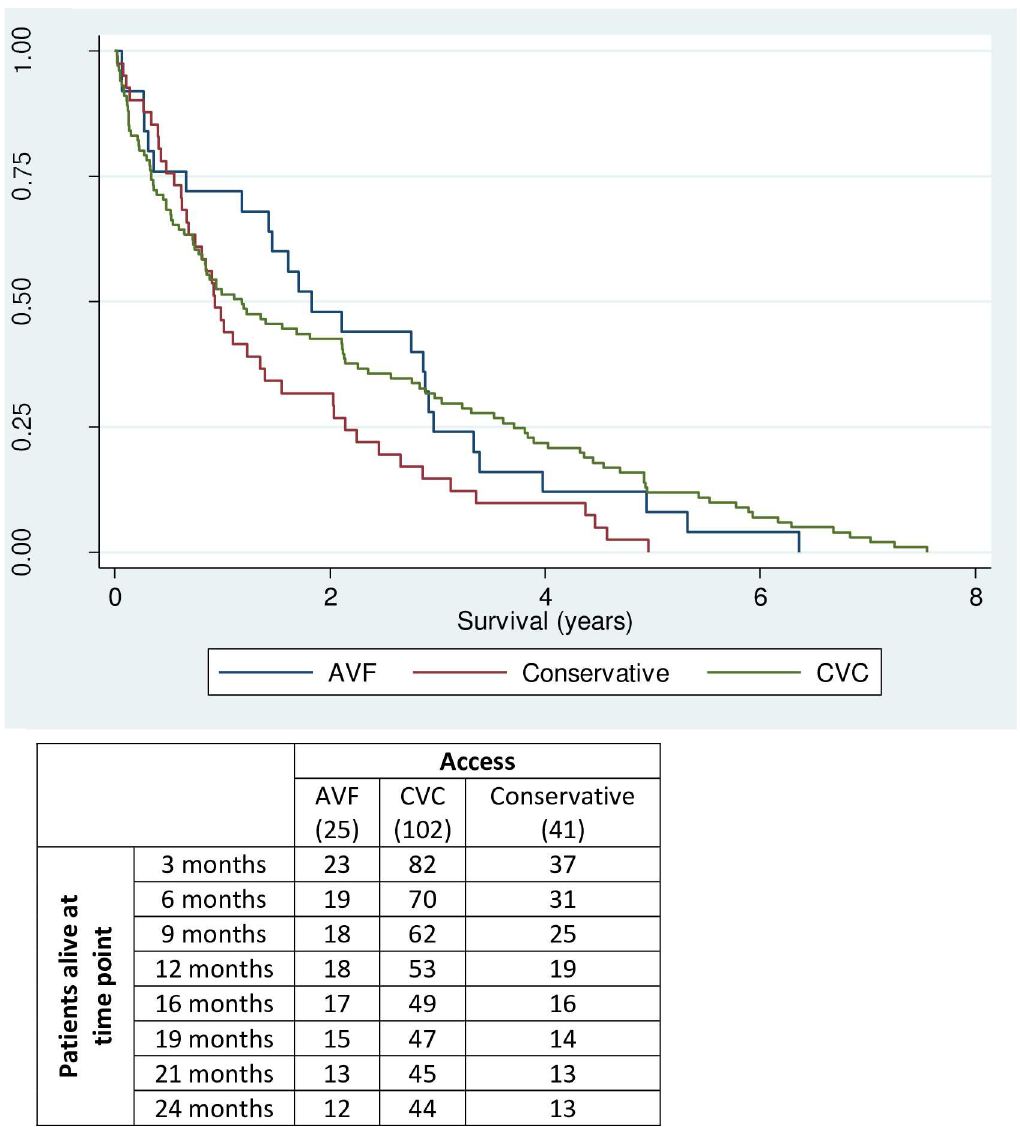
Fig 1. Unadjusted survival curve comparing the AVF, CVC and conservatively managed patients reaching an eGFR < = 10ml/min/1.73m 2 .